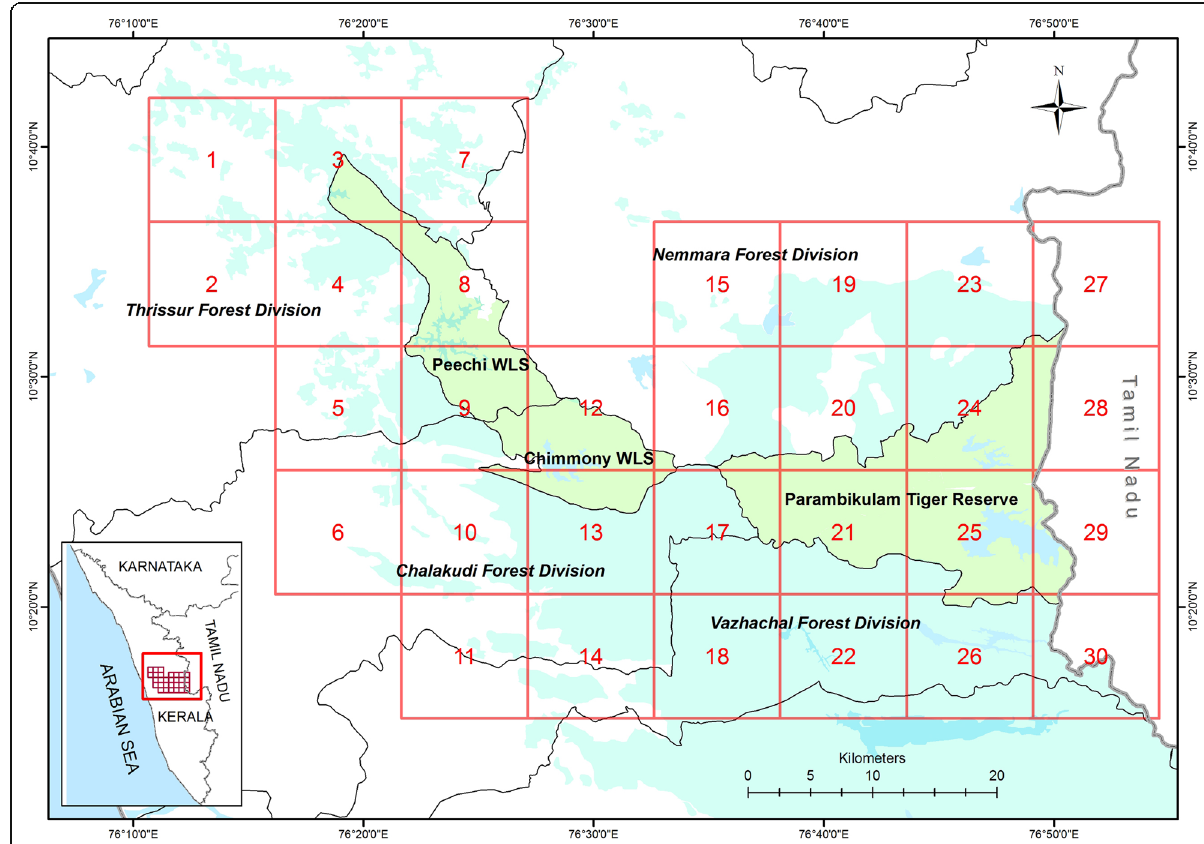
Fig. 2 Study area divided into 30 grids of 10 km × 10